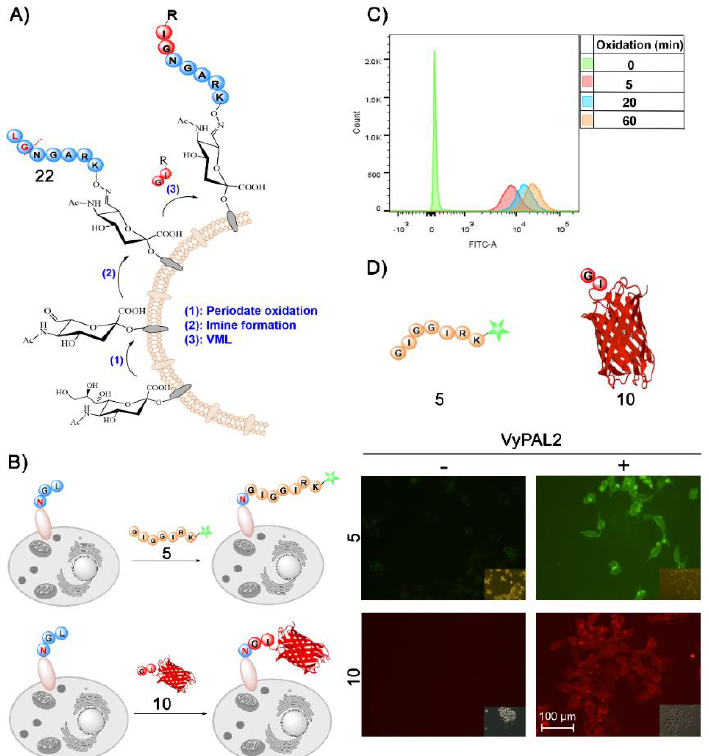
Figure 8. A cell surface modification strategy based on consecutive oxime ligation and VML. ( A ) Schematic illustration of cell surface modification in three steps: (1) sodium periodate oxidation of